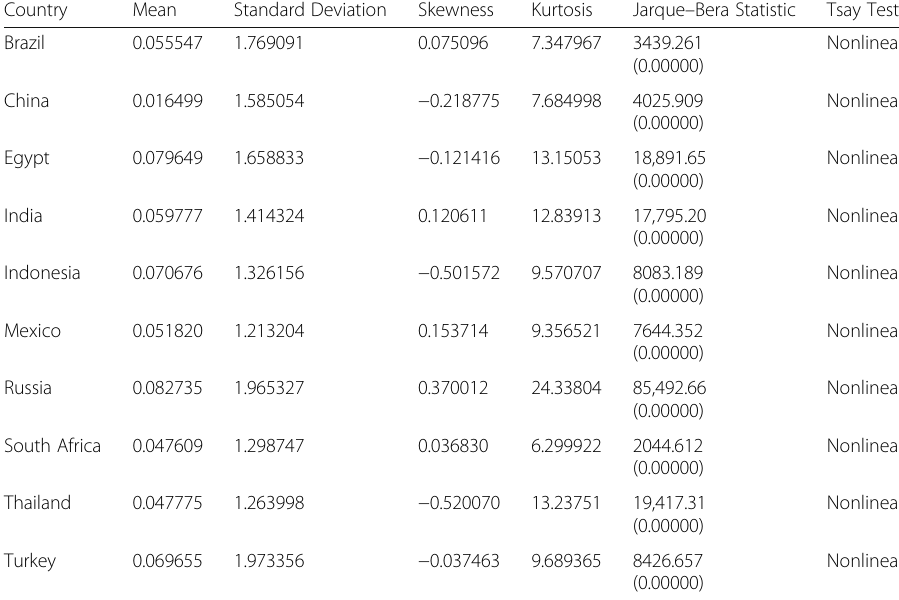
Table 2 Descriptive Statistics for Emerging